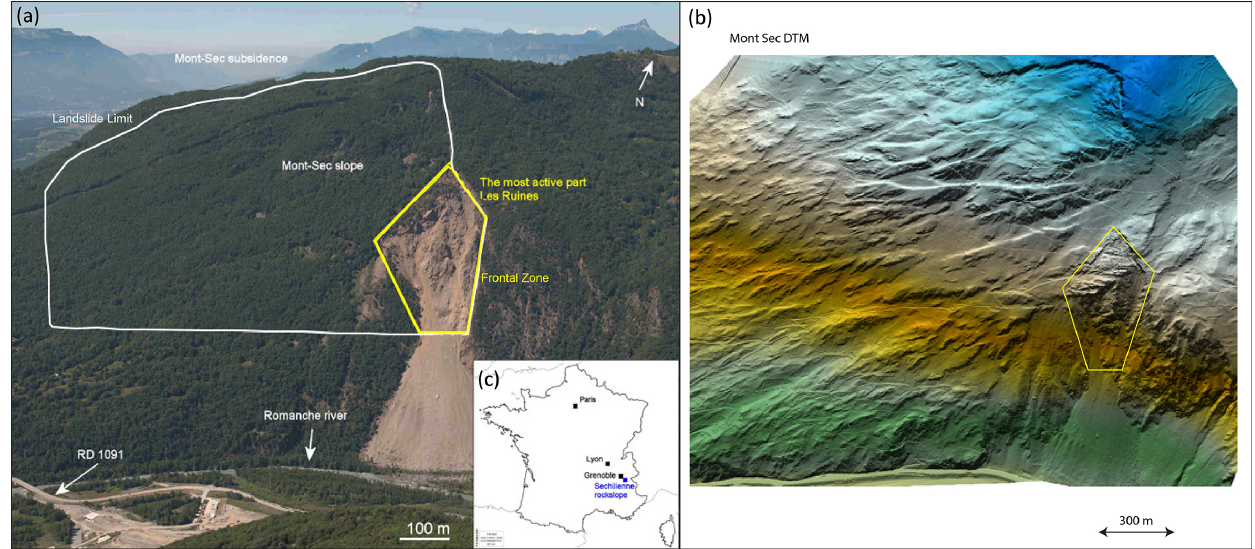
Figure 1. (a) Location of the Séchilienne rock slope in the Romanche River valley along RD 1091. The landslide is outlined in white covering an area known as the Mont-Sec slope. The most active frontal zone is outlined in yellow. (b) Digital terrain model (DTM) of the Mont-Sec slope with most active frontal zone of the landslide highlighted. (c) Location of the Séchilienne landslide within France.